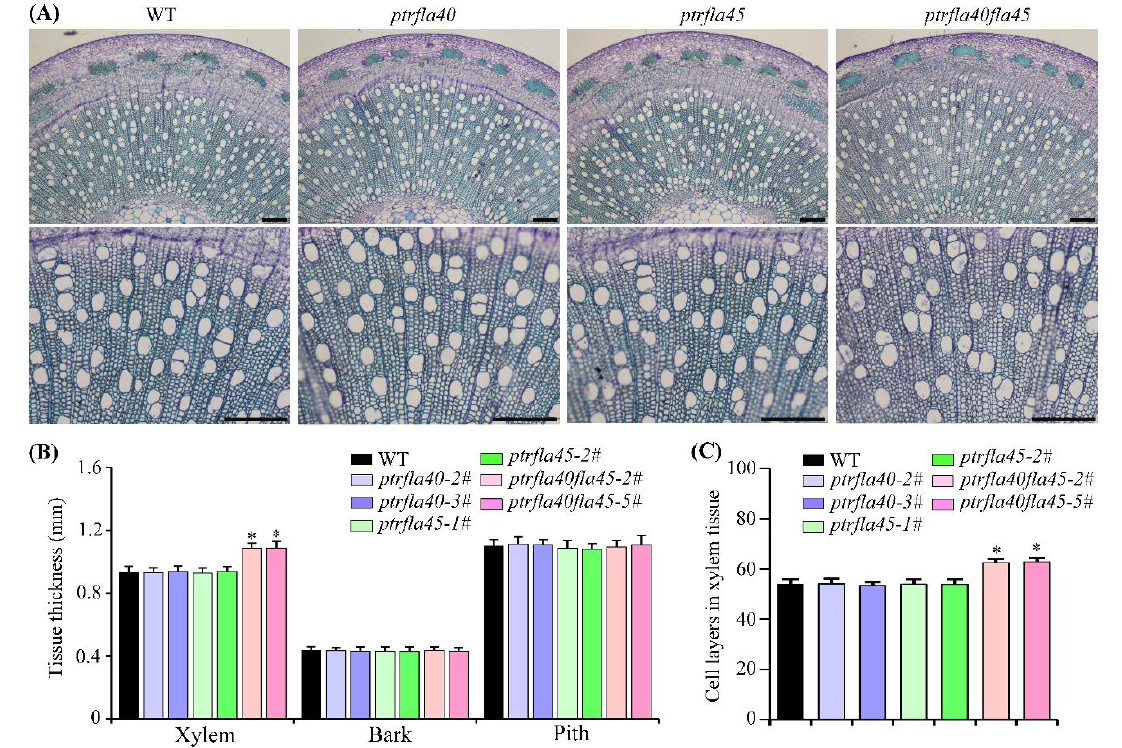
Figure 5. Microscopical observations in the stem tissues of wild-type, ptrfla40 , ptrfla45, and ptrfla40fla45 mutants. ( A ) Cross-sections of the 12th internode from 4-month-old representative wild-type (WT) plants and mutants. ( B ) Statistical analysis of the radial width of pith, xylem, and bark tissues. ( C ) Layers of xylem cells. Data are means ± SD ( n = 3). Bars: 200 μm. Student’s t -test: *, p < 0.05.